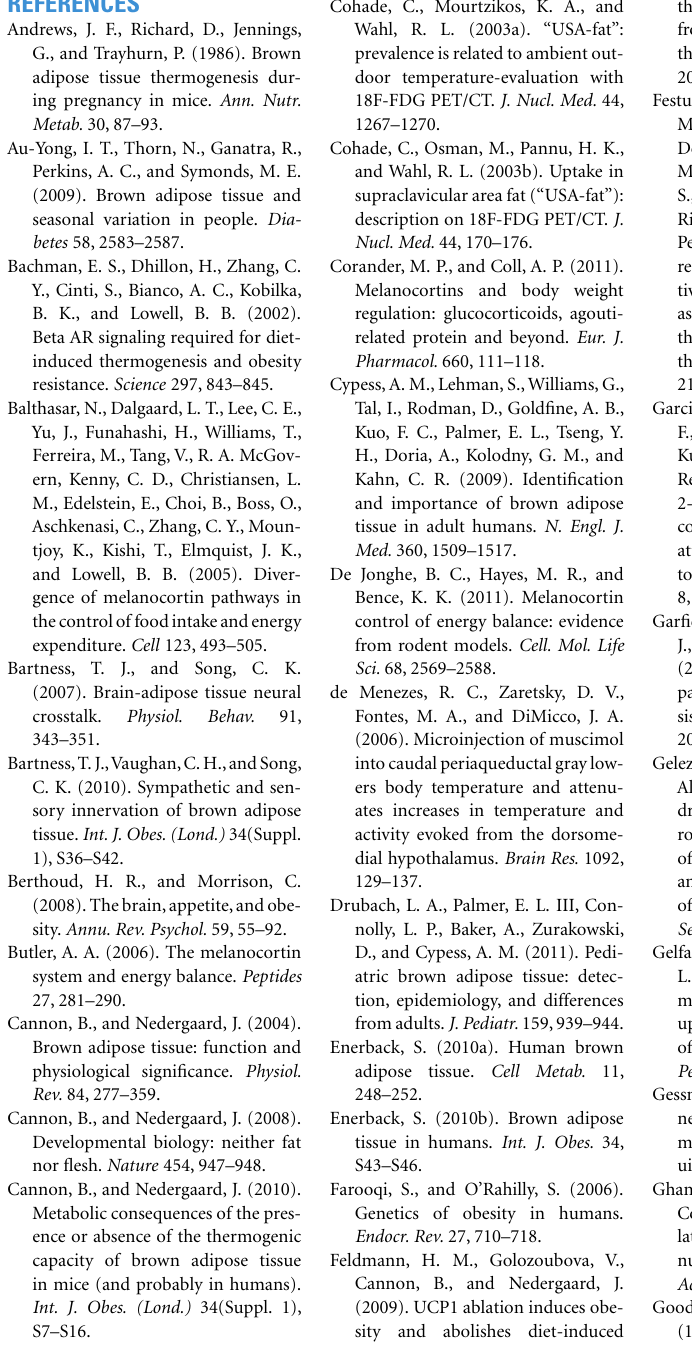
Beta(1)/beta(2)/beta(3)- adrenoceptor knockout mice are obese and cold-sensitive but have normal lipolytic responses to fasting. FEBS Lett.